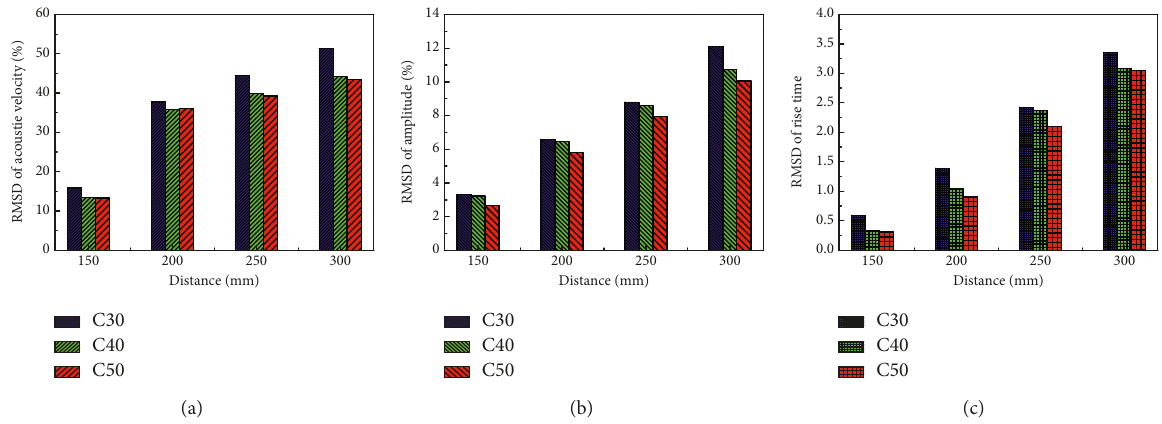
Figure 9: RMSD indexes of (a) acoustic velocity, (b) amplitude, and (c) rise